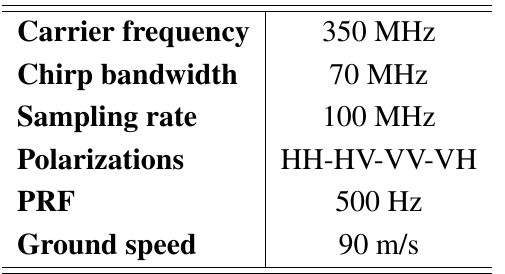
Table 1. E-SAR P-band system parameters.